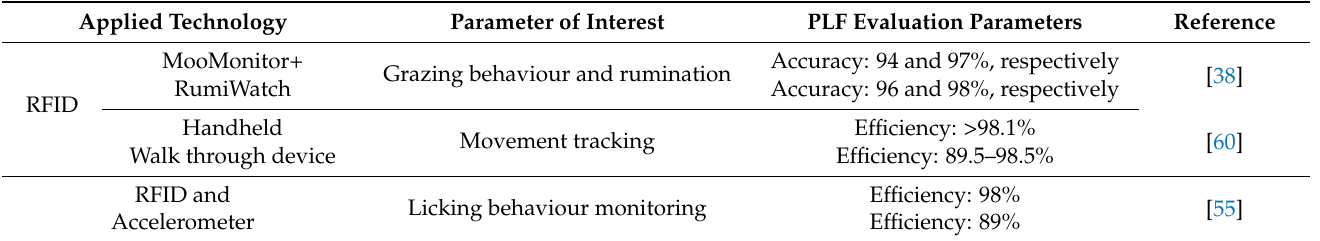
Table 1. Application of precision livestock farming advancements and their evaluation in grazing